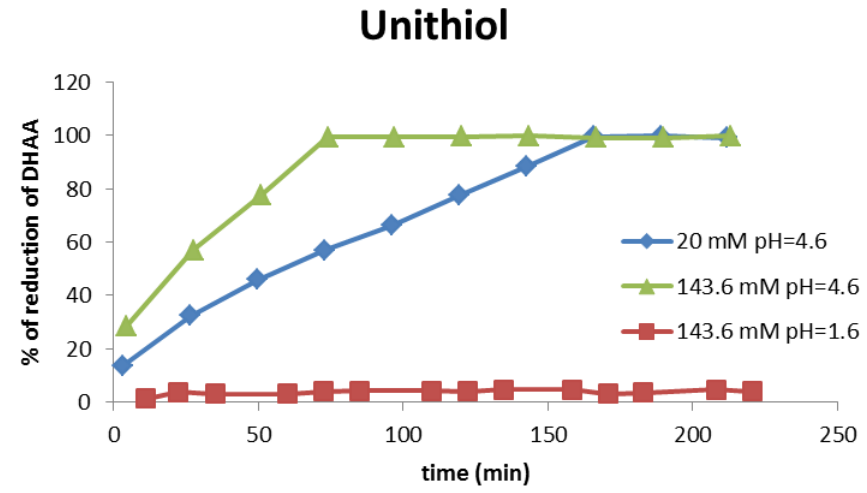
Figure 1. Degree of reduction in dehydroascorbic acid versus time, with the use of unithiol.